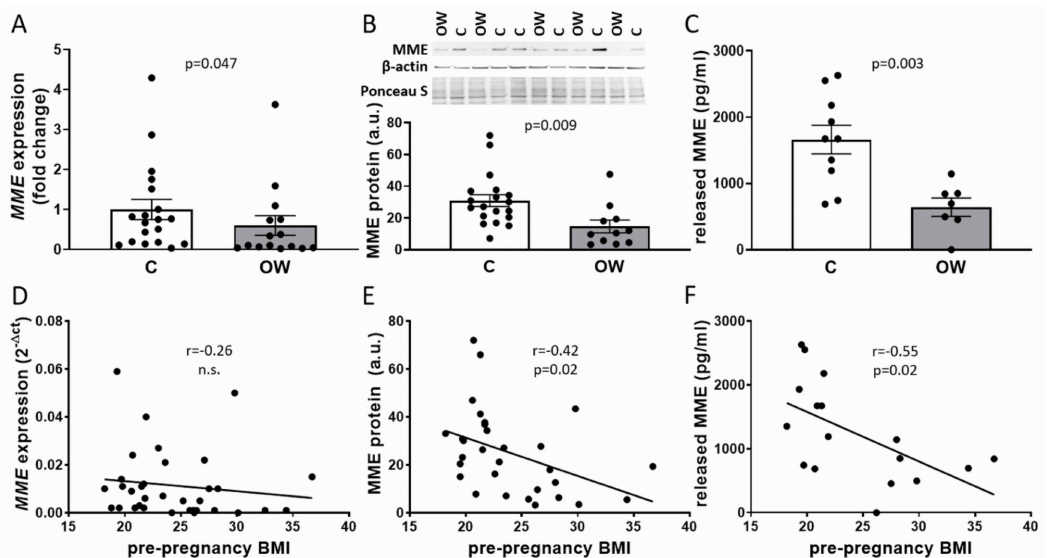
Figure 2. MME mRNA and protein in fpEC after normal and overweight pregnancy. MME mRNA ( A ), cellularprotein( B ),andreleasedMME( C )wasreducedinprimaryfpECexposedtomaternaloverweight ( t -test). When correlated to maternal pre-pregnancy BMI (Pearson correlation), this association was not significant for fpEC MME mRNA ( D ), but it was significant for fpEC protein production ( E ) and release ( F ). MME mRNA was normalized to the mean of the housekeeping genes HPRT1 and ribosomal protein L30 ( RPL30 ), respectively. A representative immunoblot for MME, β -actin, and the Ponceau S staining of the corresponding membrane are shown on top of the protein data in (B). C: controls; OW: overweight; a.u.: arbitrary units. MME mRNA: n (c) = 19; n (ow) = 15; cellular MME: n (c) = 19; n (ow) = 11; MME release: n (c) = 10; n (ow) = 7. The bars in ( A – C ) represent the mean ± SEM.